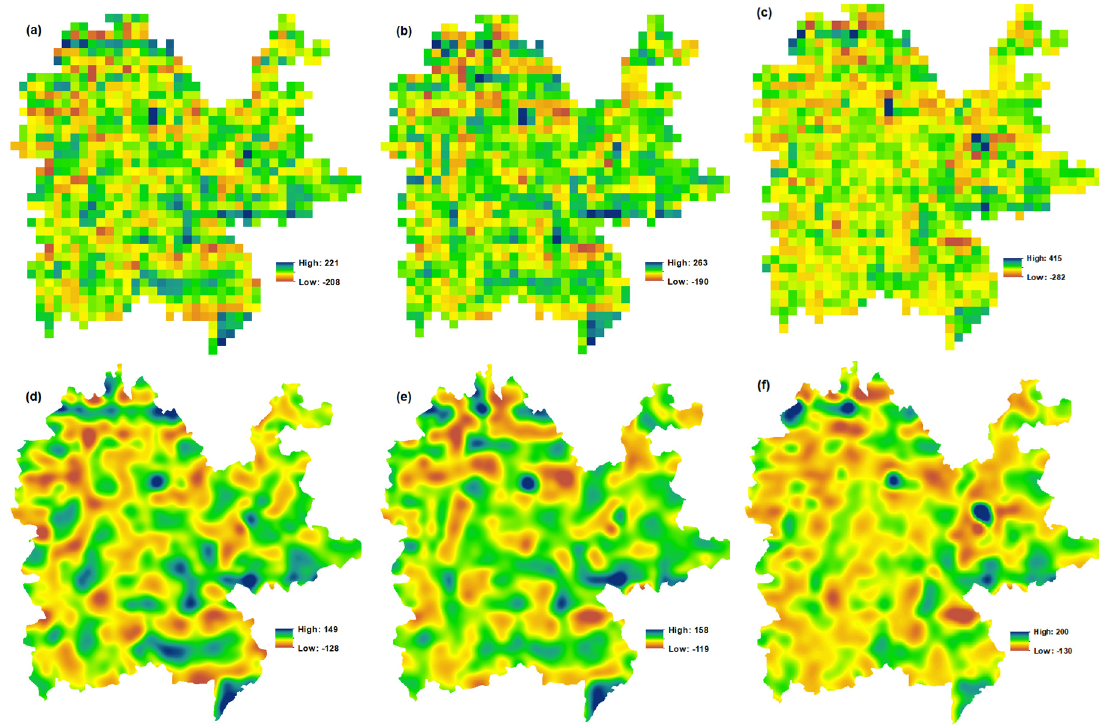
Figure 6. The residuals precipitation at coarse resolution (NDVI ( a ), EVI ( b ), and LAI ( c )) and fine resolution (NDVI ( d ), EVI ( e ), and LAI ( f )) for the year 2018.